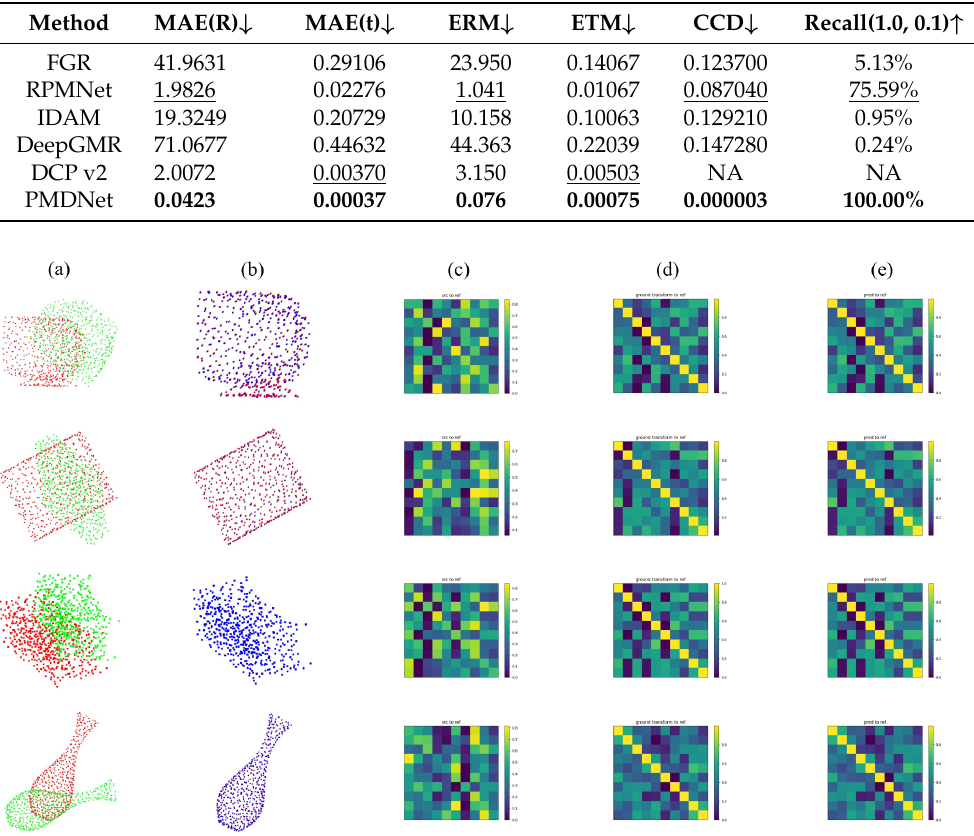
Figure 7. Qualitative results of the PMDNet on unseen categories. ( a ) source and reference clouds. ( b ) reference and predicted clouds. ( c ) correspondence between source and reference. ( d ) ground- truth correspondence. ( e ) correspondence between predicted and reference